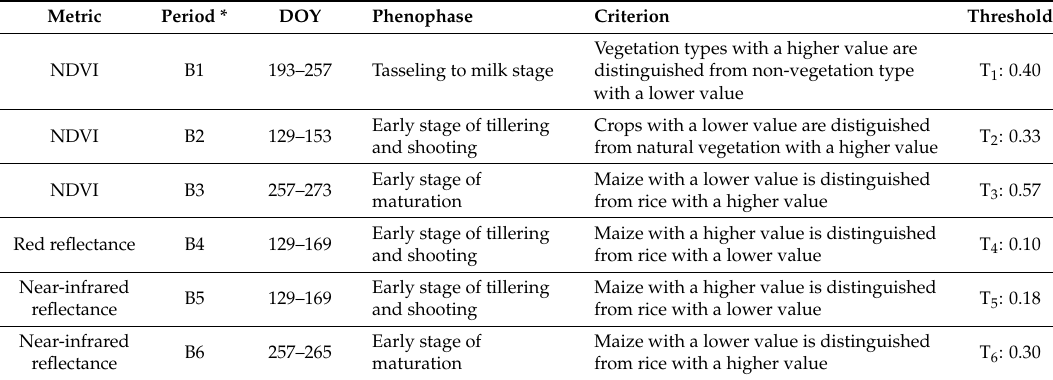
Figure 6. Frequency distribution of the training samples for different land cover types. B1–B6 correspond to the time windows in Figure 5. Red thick vertical lines show the locations of discrimination thresholds in Table 2. Table 2. The visually-determined discrimination thresholds for each metric in different periods.